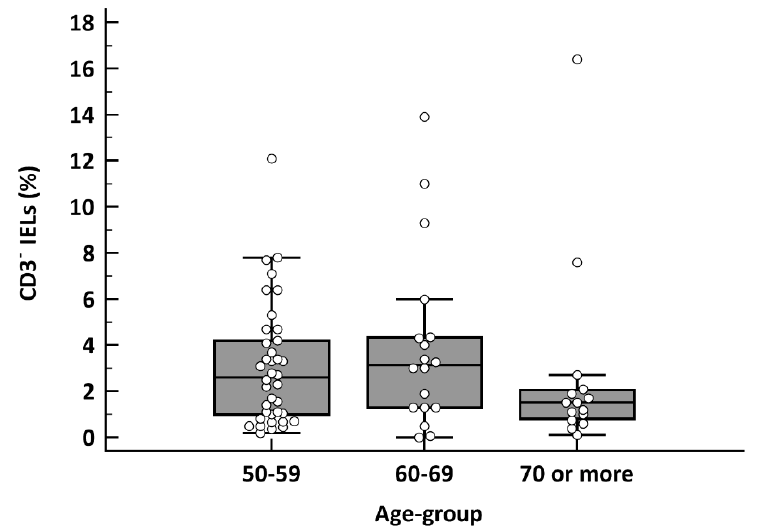
Figure 1 . Box-plot chart of TCR γδ + cells in CD patients with villous atrophy ( n = 71), depending on the different age groups ( p = 0.009; Kruskal–Wallis test).